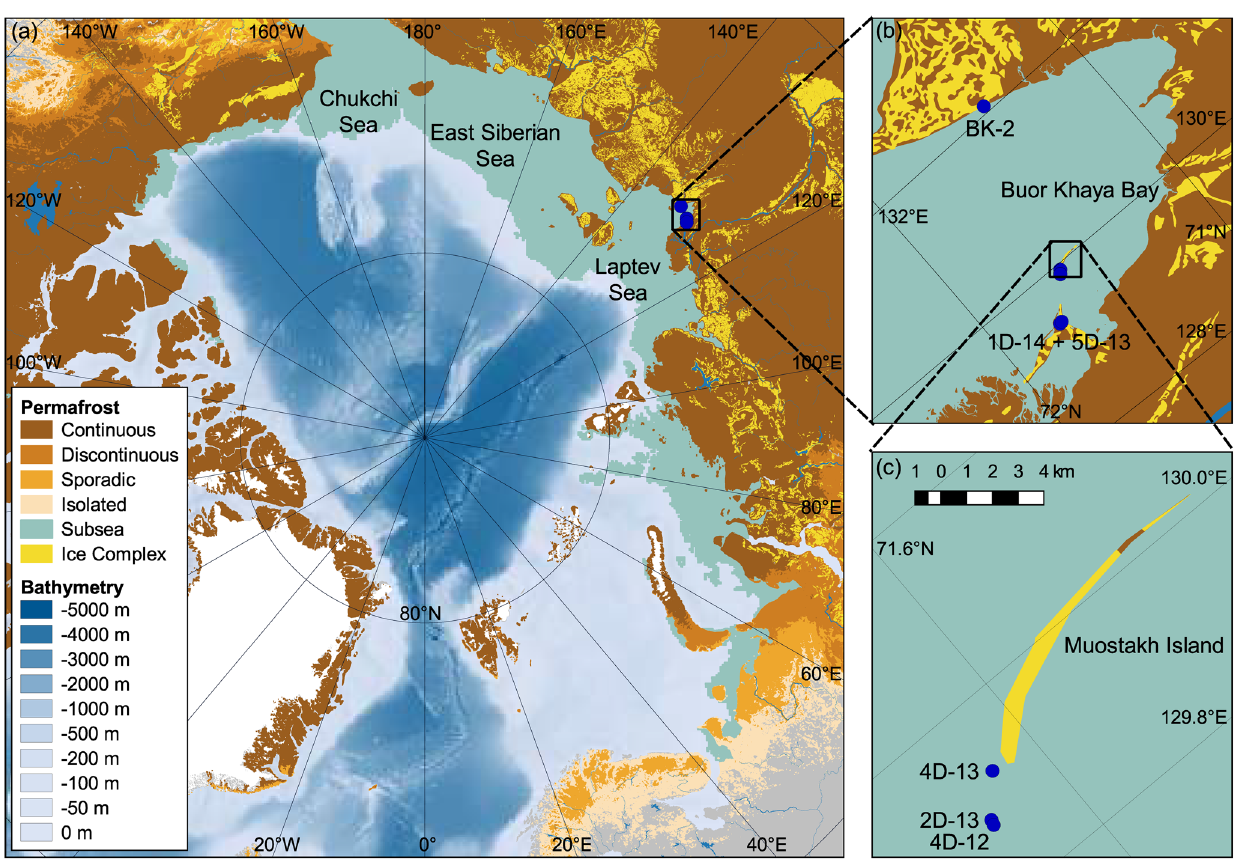
Fig.1|Arcticpermafrostextent.a Shownaresubsea 1 andterrestrial 69 permafrost, including Ice Complex deposits 70 . Detailed maps show b the Buor-Khaya Bay, with subseapermafrostdrillsitesdescribedinthis(4D-13,2D-13,4D-12,1D-14,5D-13)and